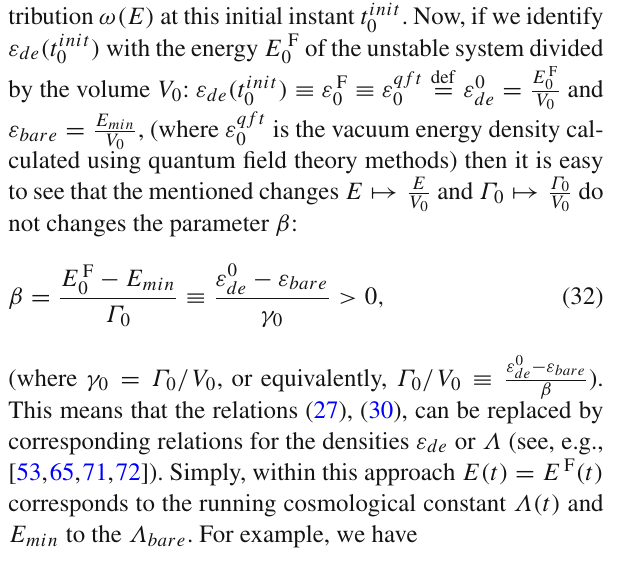
initial unstable state | φ (cid:6) ≡ | 0 (cid:6) F at t = t init into eigenvectors | E (cid:6) of H , (where E ∈ σ c ( H ) ), and